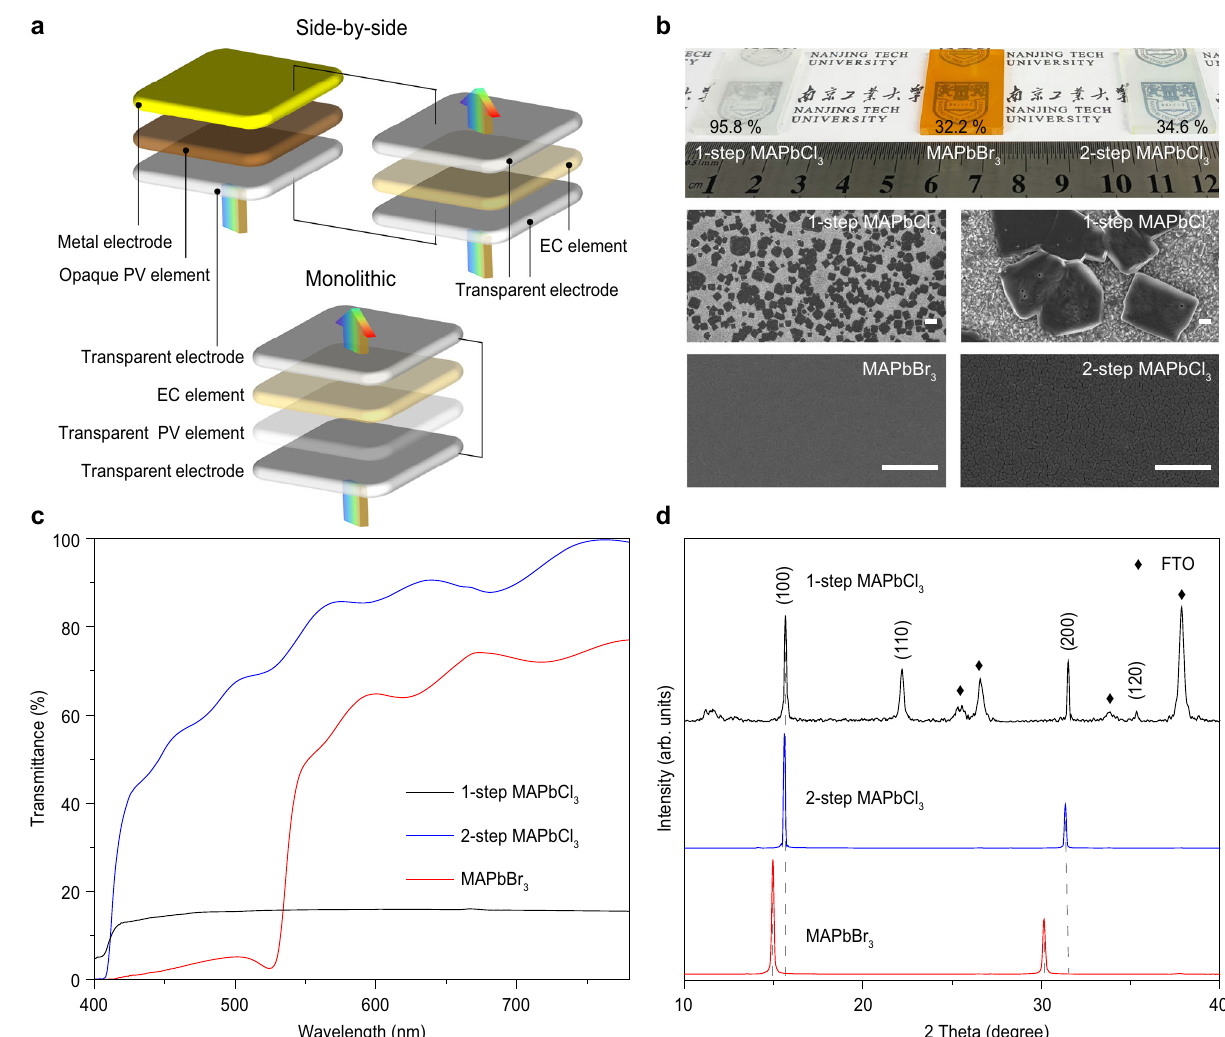
Fig. 1 Evolution on architectures of PVCDs and characterization of perovskite fi lms. a Four-terminal side-by-side PV-EC device architecture: two terminals of PV element and two terminals of EC element were connected via two external circles. Two-terminal monolithic integrated PVCD architecture in this work: only one external circle required to connect top and bottom terminals, which is the most ideal structure for achieving full-frame active area and high transmittance synchronously. b The photographs and SEM images of 1-step MAPbCl 3 , MAPbBr 3 and 2-step MAPbCl 3 fi lm respectively. Scale bar is 5 μ m. c The transmittance spectra of 1-step MAPbCl 3 , MAPbBr 3 and 2-step MAPbCl 3 fi lms. d X-ray diffraction patterns of 1-step MAPbCl 3 , MAPbBr 3 , and 2-step MAPbCl 3 fi